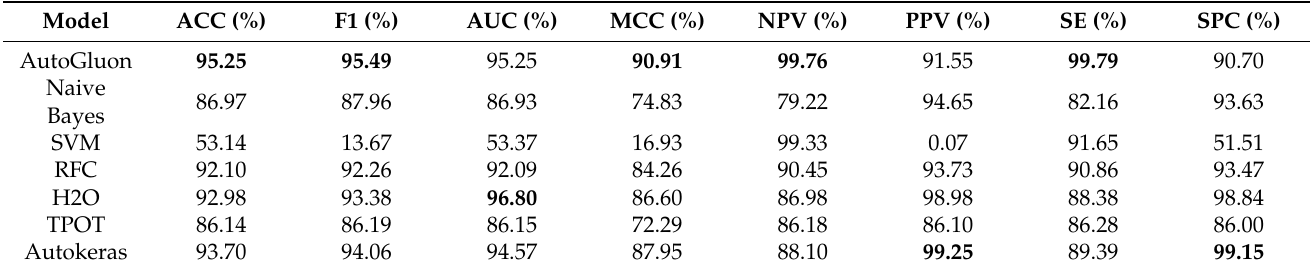
Table 2. Performance comparisons among five automated machine learning frameworks and three conventional machine learning